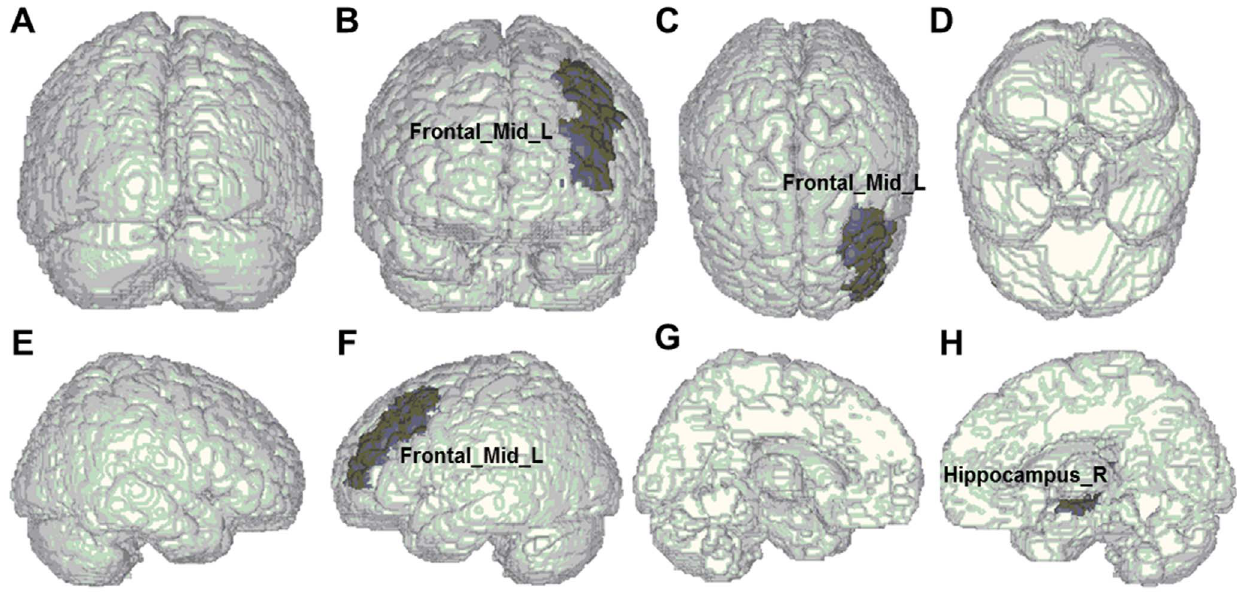
Figure 2. Anatomical regions exhibiting significant differences of cortical shape complexity between remitting depressed patients and healthy controls. In comparing remitting patients with healthy controls, the significant differences of the curvedness values were only in the sulcal pits of the left middle frontal gyrus (Frontal_Mid_L) and the right hippocampus (Hippocampus_R) as shown in (A) posterior, (B) anterior, (C) superior, (D) inferior (E) right-lateral, (F) left-lateral, (G) left-medial, and (H) right-medial views.